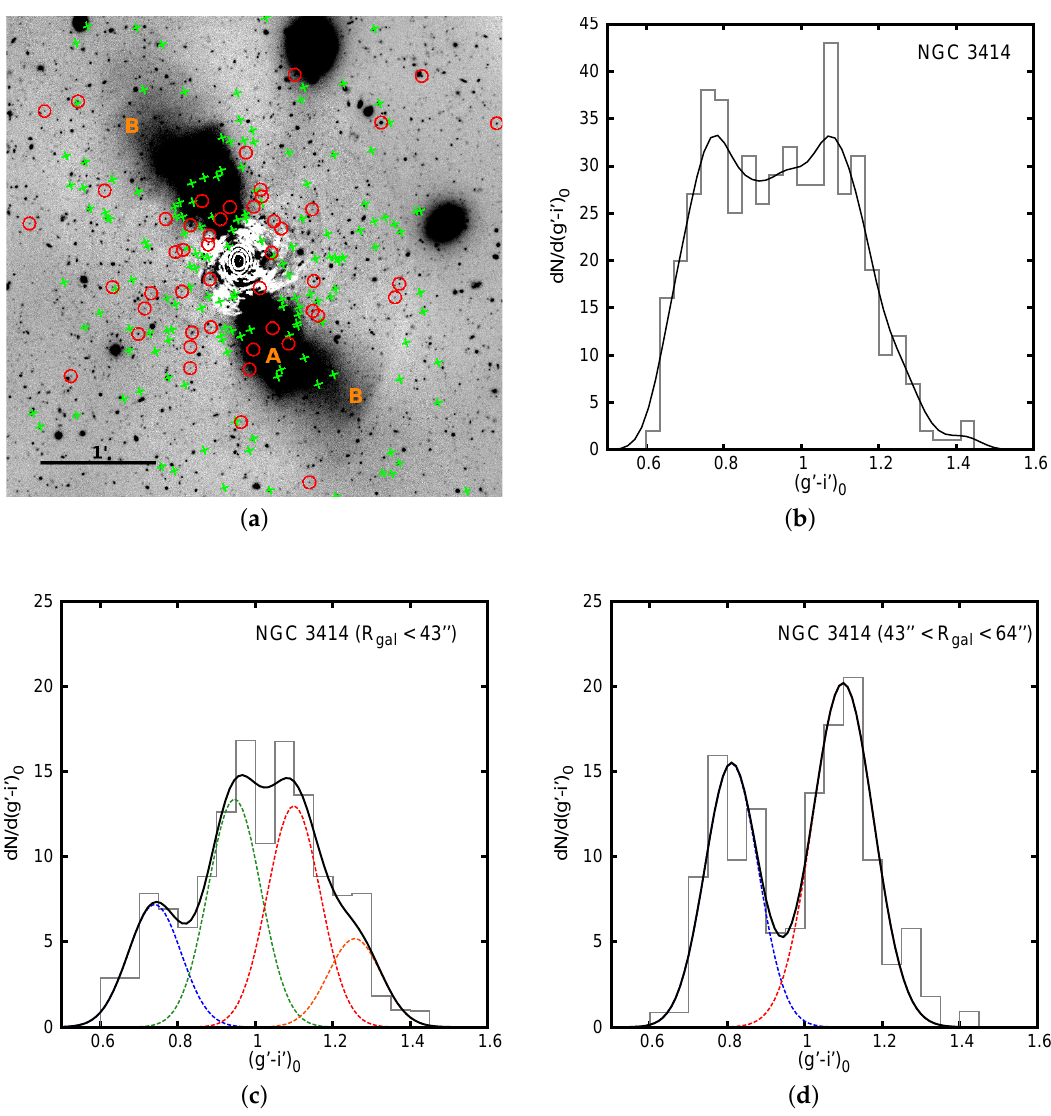
Figure 2. ( a ) Image after the galaxy light is removed. The orange letters A and B indicate the bar/disk and the shells structures, respectively. Red circles and green crosses show the position of the GC candidates with the reddest colour ( g (cid:48) − i (cid:48) ) 0 and those with intermediate colour, respectively. ( b ) Colour histogram ( g (cid:48) − i (cid:48) ) 0 for the GC candidates of NGC3414. Solid black line represents the smoothed colour distribution. ( c , d ) Colour histograms with the GC candidates according to the galactocentric distance < 43 and 43 − 64 arcsec, respectively. The dashed lines show the Gaussian fit performed for each GC